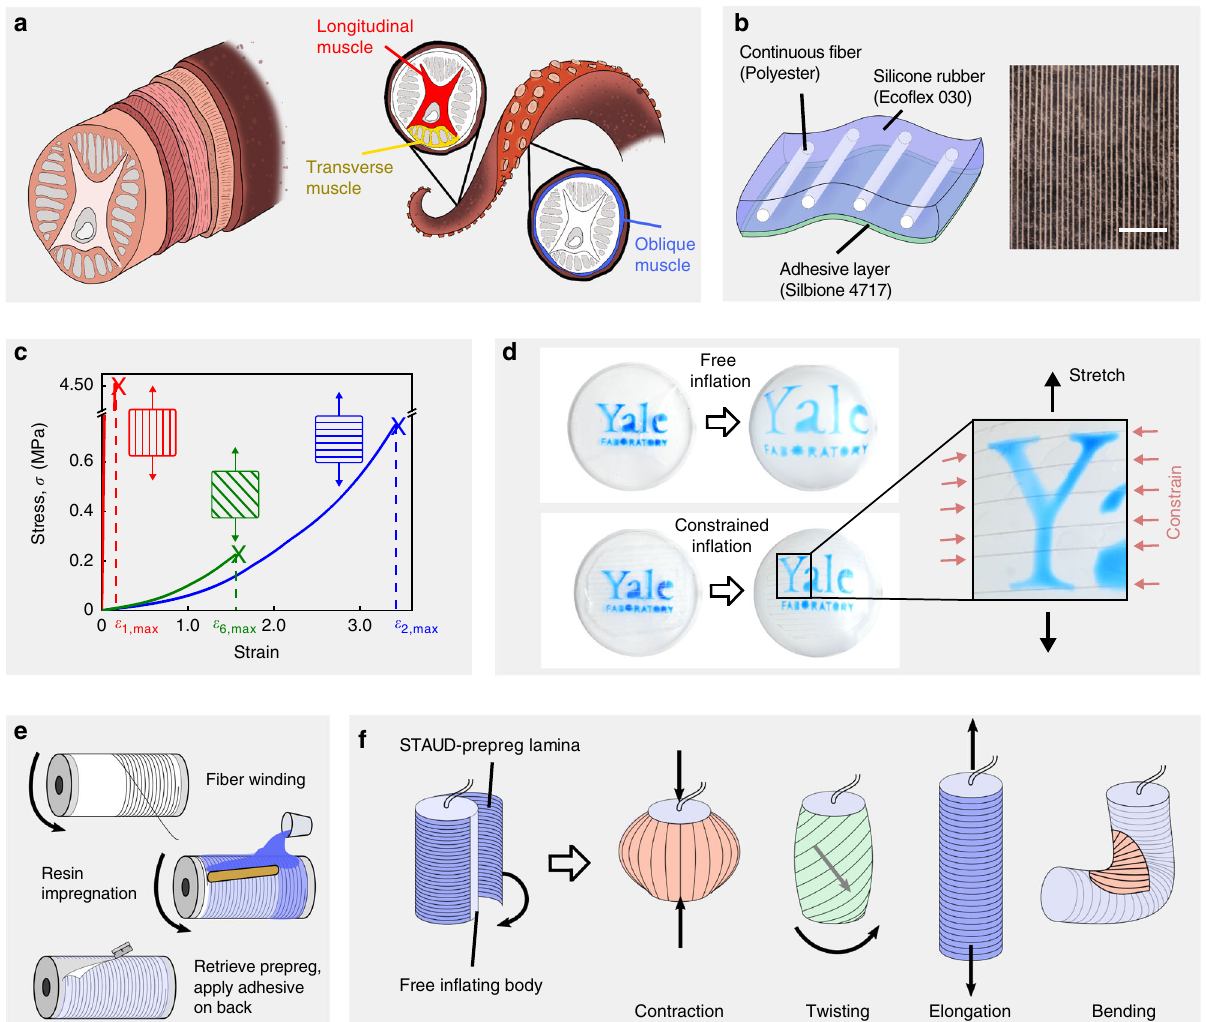
Fig. 1 Overview and working principle of STAUD-prepreg. a Illustration of laminated layers of unidirectional muscle fi bers in a muscular hydrostat in cephalopod tentacles and the working mechanism for achieving complex motion. b Schematic and optical micrograph of stretchable adhesive unidirectional prepreg (STAUD-prepreg). Scale bar: 10 mm. c Quasi-static uniaxial tensile testing results of STAUD-prepreg laminae with respect to different fi ber orientations ( θ = 0°, 45°, 90° from left). d Photographs of in fl ating planar soft body. Free in fl ation (top) with uniform radial expansion and constrained in fl ation (bottom) with one adhered lamina at θ = 90°. e Schematic of fabrication process for STAUD-prepreg using a bench-top fi ber winder. f Illustration of cylindrical actuators with one STAUD-prepreg lamina adhered, and the ensuing in fl